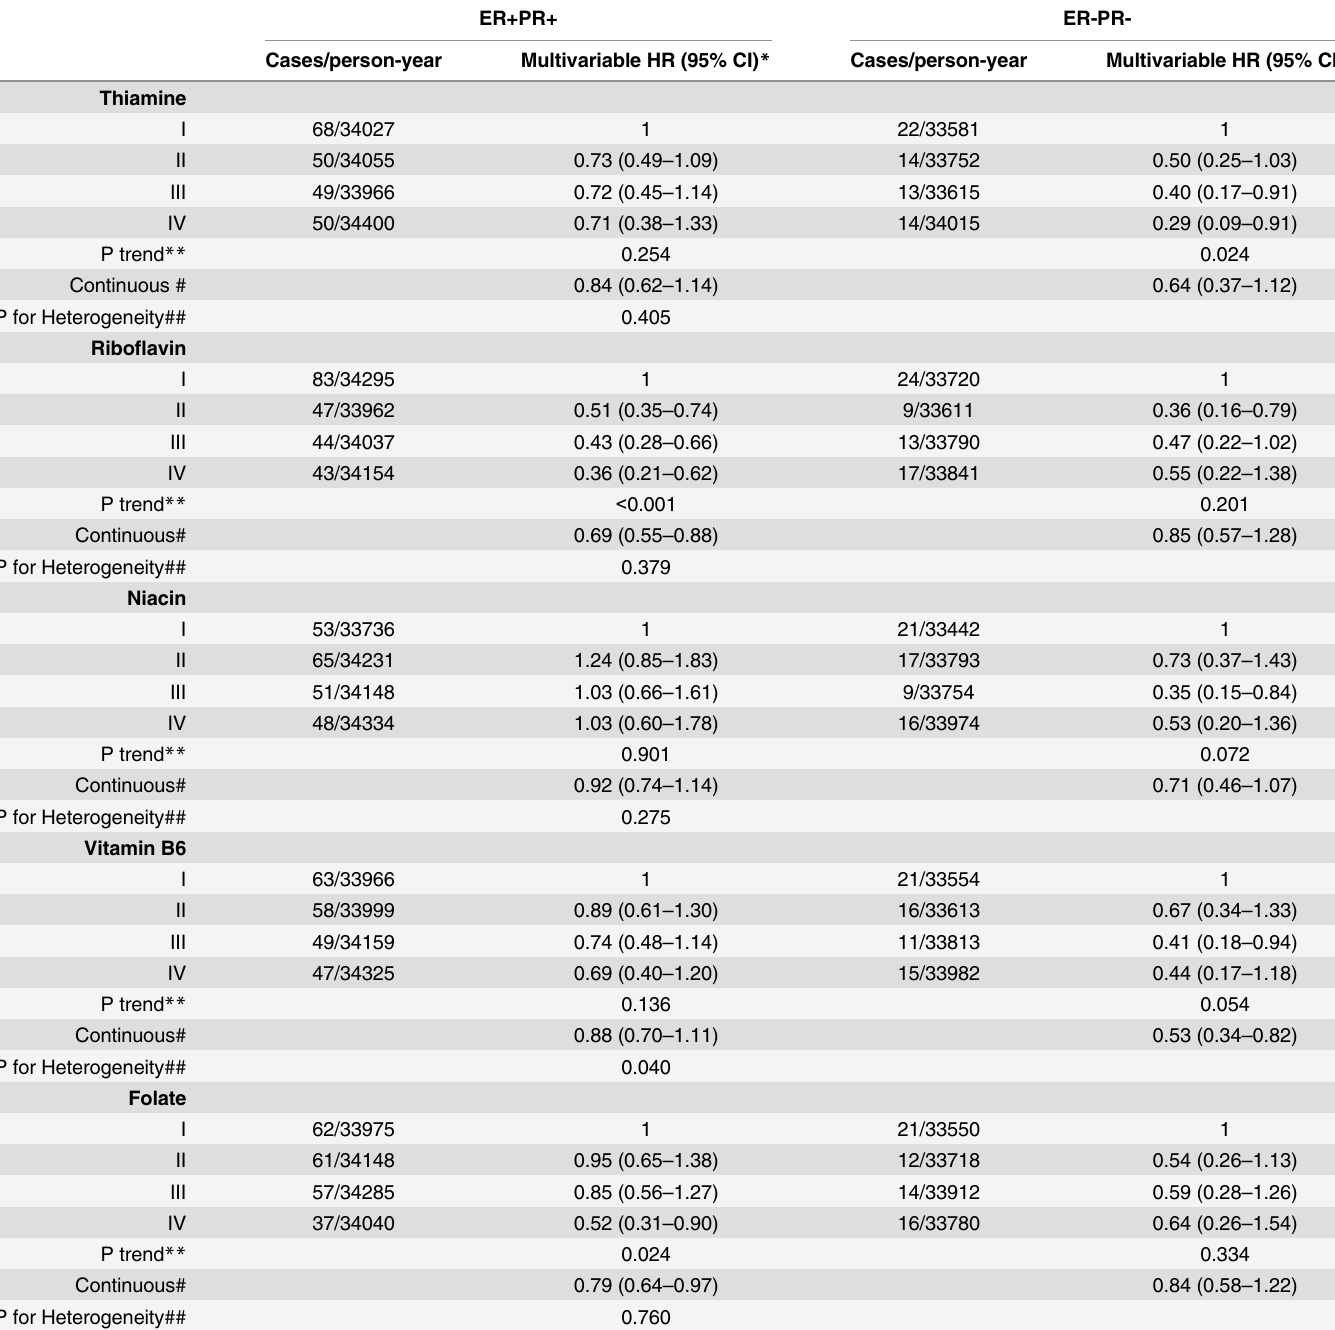
Table 4. HRs (95% CIs) of breast cancer by ER plus PR status in relation to quartiles of B vitamin intake in ORDET